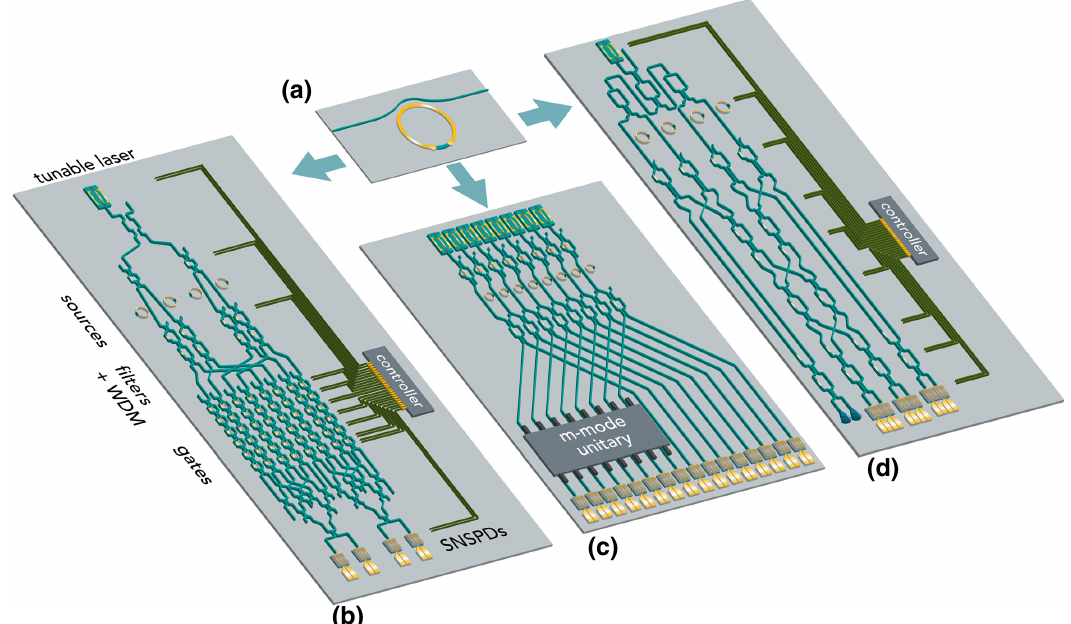
FIG. 5. (a) The tunable AlGaAs-on-insulator (AlGaAsOI) microring-resonator entangled-photon-pair source. The AlGaAsOI plat- form enables the large-scale integration of active and passive quantum photonic components, including tunable lasers, nonlinear quantum light sources, filters and wavelength-division multiplexing (WDM), superconducting-nanowire single-photon detectors (SNSPDs), and microcontrollers. These components can be monolithically integrated for all-on-chip quantum photonic circuits, includ- ing (b) quantum gates for optical computing, (c) m -mode unitary operations for boson sampling, and (d) Bell-state measurements for chip-to-chip teleportation of quantum